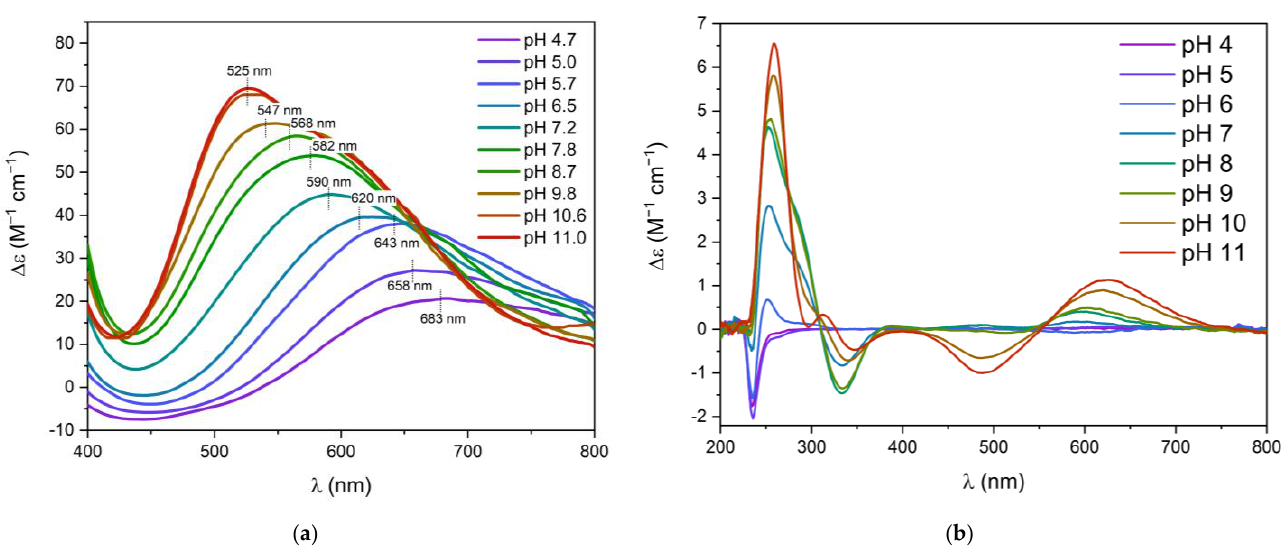
Figure 1. ( a ) Vis absorption spectra and ( b ) CD spectra of Cu 2+ complexes with L1 at different pH values; M:L ratio 0.8:1. C M = 0.63 × 10 – 3 M, optical path 1 cm. The wavelength of maximum absorption is reported for each Vis absorption spectrum.